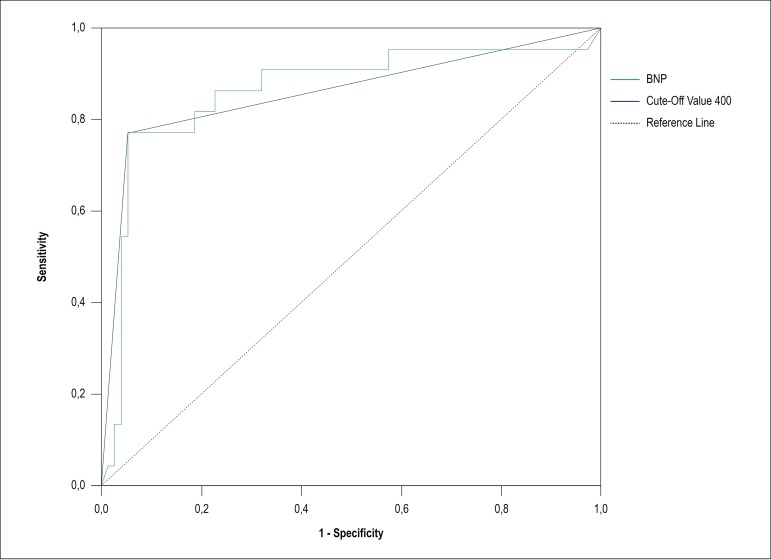
Receiver Operating Characteristic (ROC) Curve analysis shows the cut-off value of NT-pro BNP to predict left ventricular aneurysm.